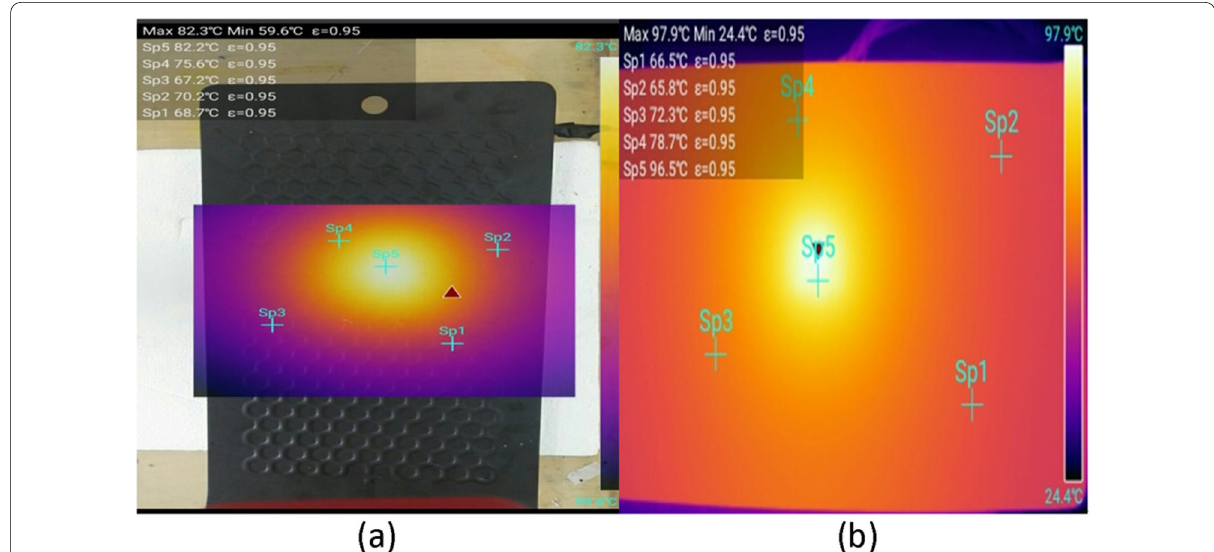
Figure 6 Temperature distribution in a the micro-channel radiator and b an aluminium plate under the same input power of 90 W